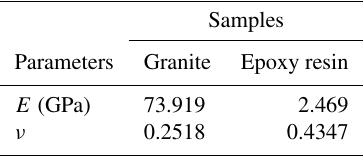
Table 4. Table of mechanical parameters of the materials. Table 5. Calibration loading conditions of the FBG